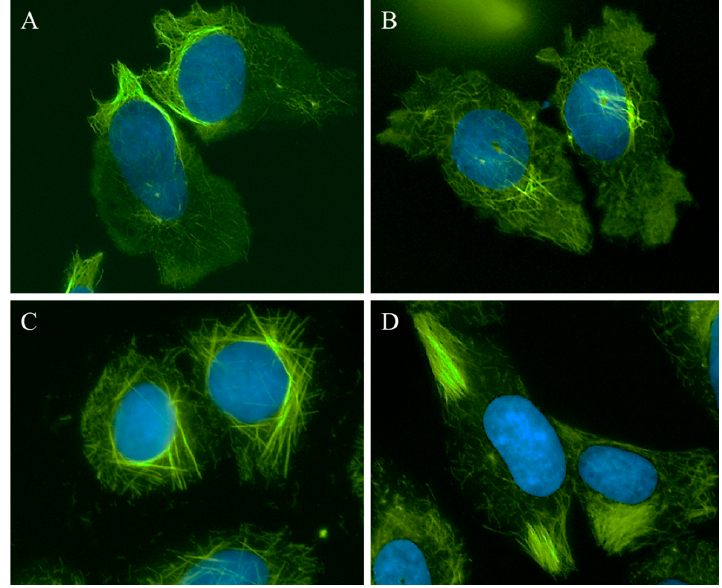
Figure 3. Microtubule stabilization and destabilization elicited by Janus compounds. HeLa cells were treated with: ( A ) 50 μ M 1 ; ( B ) 60 μ M 2 ; ( C ) 30 μ M 3 ; or ( D ) 35 μ M 4 for 18 h. Microtubules were visualized by indirect immunofluorescence (green) and DNA with DAPI (blue).